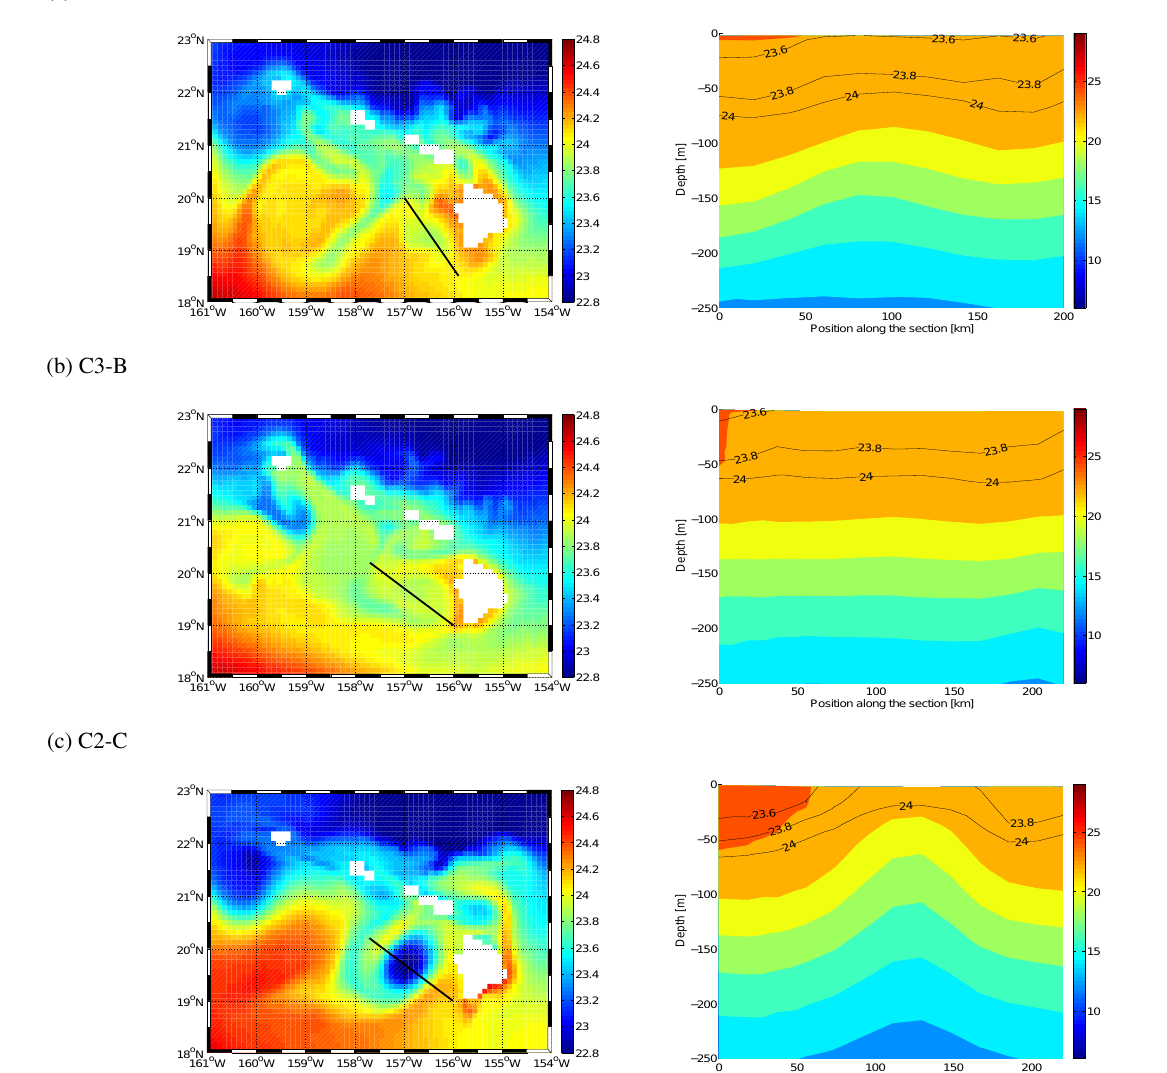
Fig. 9. Left: surface temperature maps on 28 March with position of the transects (black straight line) crossing the center of a cyclonic eddy Run-A (top), Run-B (middle) and Run-C (bottom). Right: corresponding vertical sections of temperature. The black lines in the vertical sections represent σ t , σ t and σ t isopycnals. 23 . 6 23 . 8 24